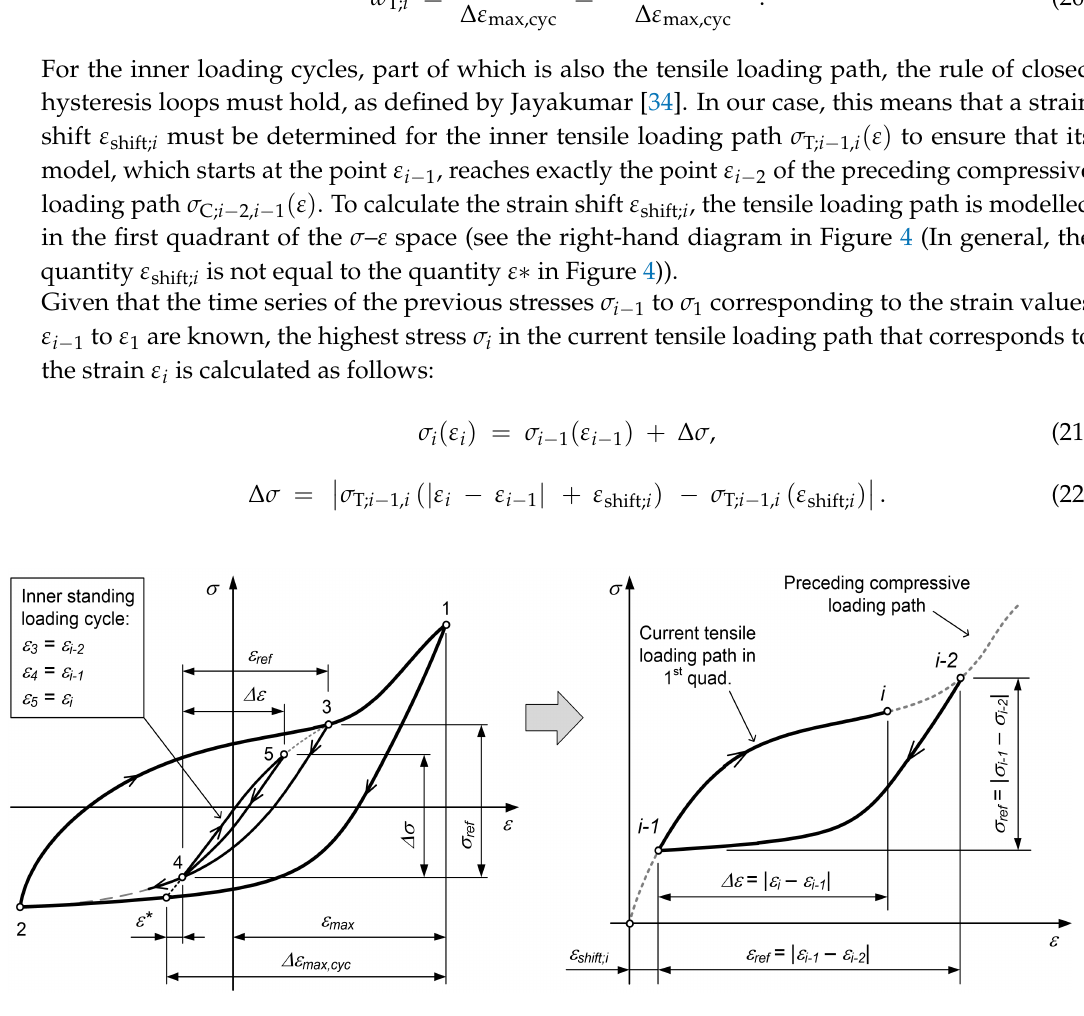
Figure 4. Modelling the tensile loading path that originates from the inner compressive loading